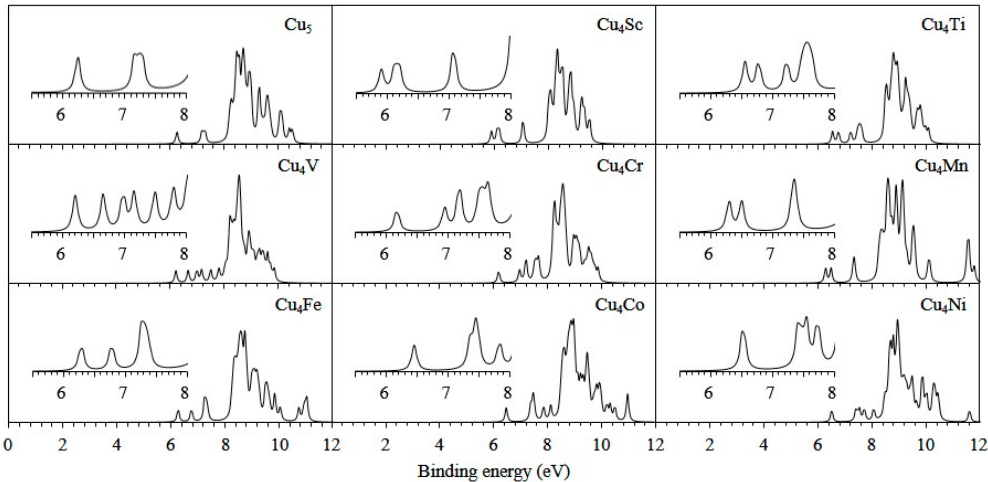
Figure 7. Simulated PES of the ground state Cu 4 M (M = Sc-Cu) clusters.